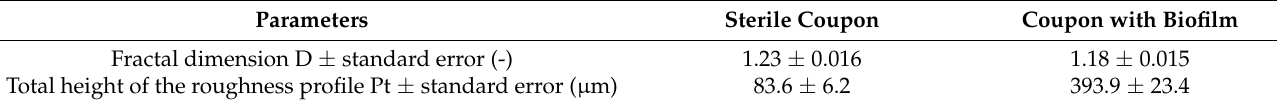
Table 3. Morphology of the surface of sterile coupon and coupon with formed biofilm. Parameters Sterile Coupon Coupon with Biofilm Fractal dimension D ± standard error (-) 1.23 ± 0.016